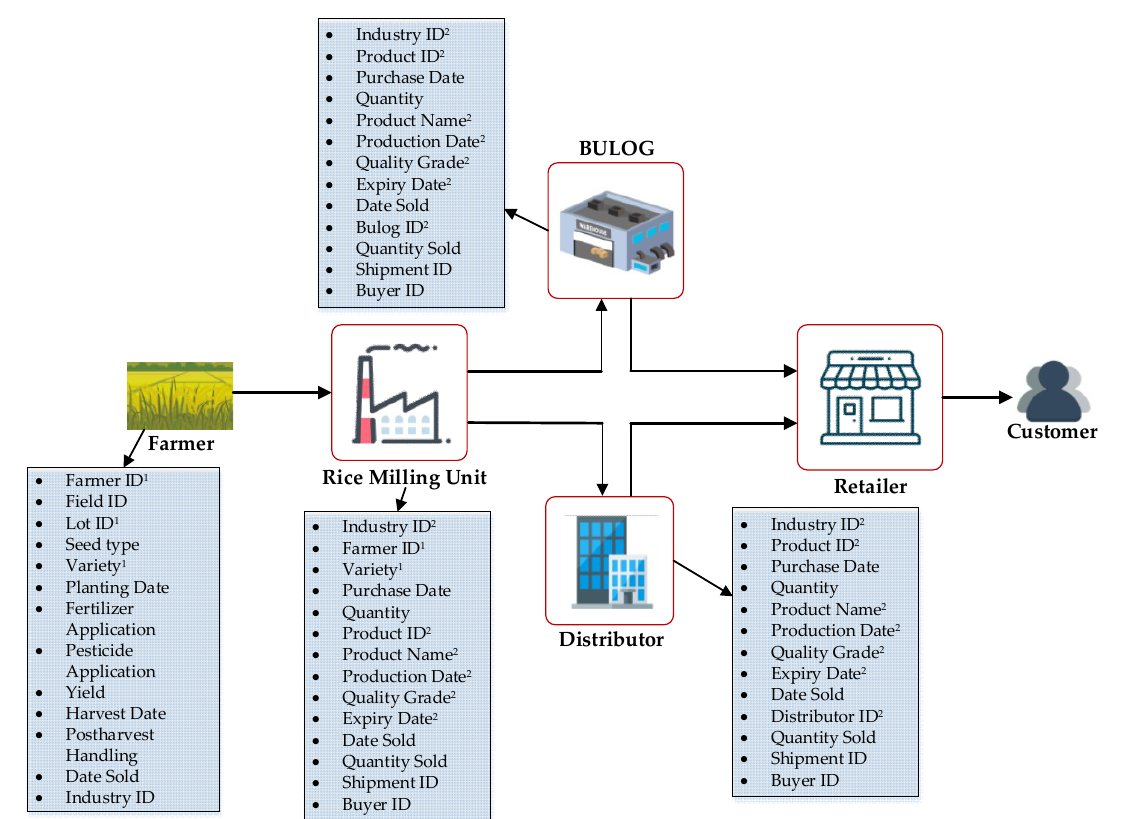
Figure 6. Forwarded information between stakeholders.